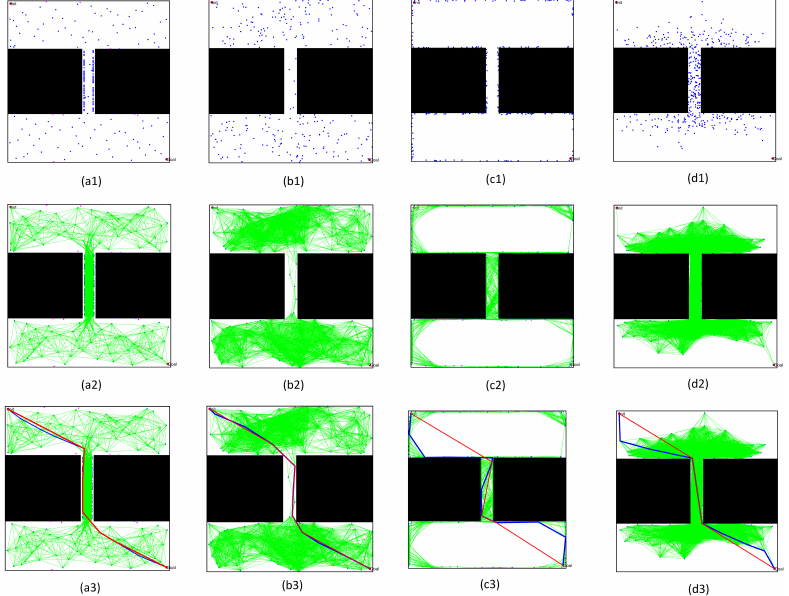
Figure 22. Results of various PRM algorithms in the environment with a straight channel: ( a1 – a3 ) based on the sampling method proposed in this paper; ( b1 – b3 ) based on random sampling method; ( c1 – c3 ) based on Gaussian sampling method; and ( d1 – d3 ) based on Bridge sampling method.